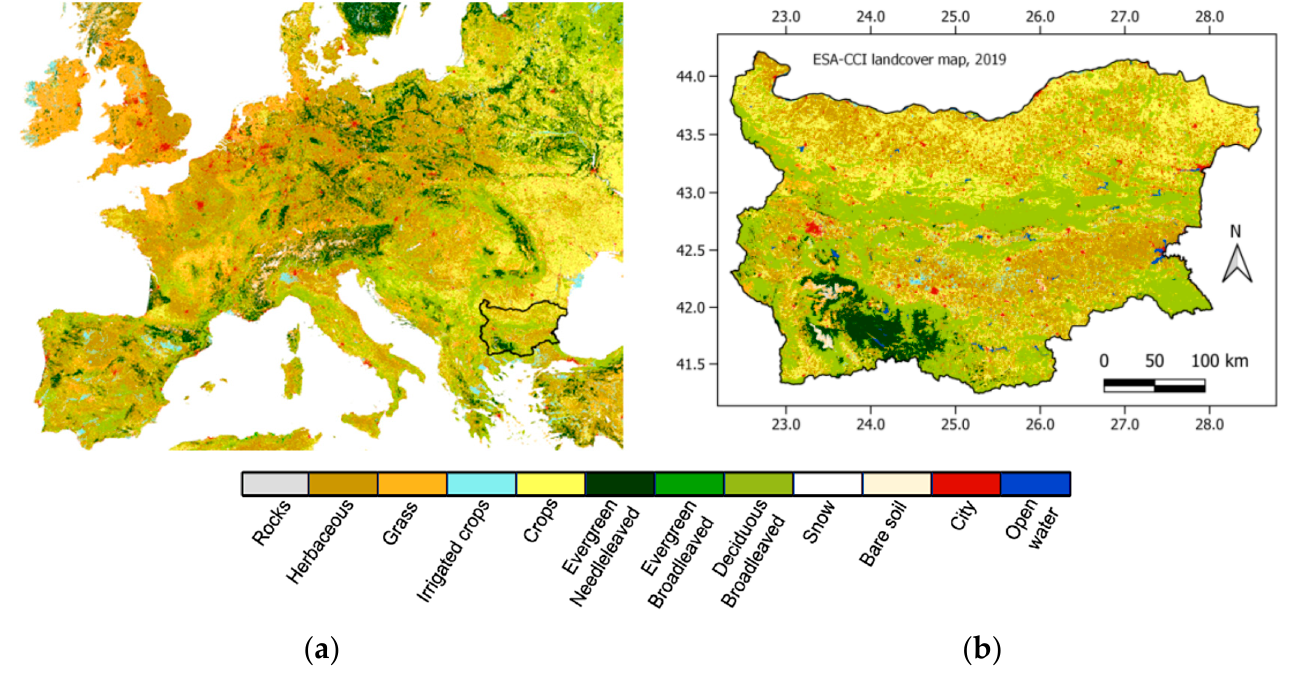
Figure 1. General location of target region against the background of the land cover types from the ESA-CCI Land Cover Map using the 2019 classification. For the purposes of the study, vegetation types were reclassified as considered by the ET algorithm [74]: ( a ) Europe; ( b ) Bulgaria, SEE. Spatial heterogeneities in land cover explain why the underlying surface conditions of Bulgaria are different and significantly affect the drought propagation process. Information about land cover (LC) provided by the ESA-CCI Land Cover Map at a spatial resolution of 300 m (https://www.esa-landcover-cci.org/?q=node/164, accessed on 20 June 2020) was used to illustrate the variability in vegetation, which has a key role in the variations in ET in Bulgaria. The last LC Map edition from 2019 was used, as the main LC types were reclassified for demonstration purposes according to the ET algorithm [81].